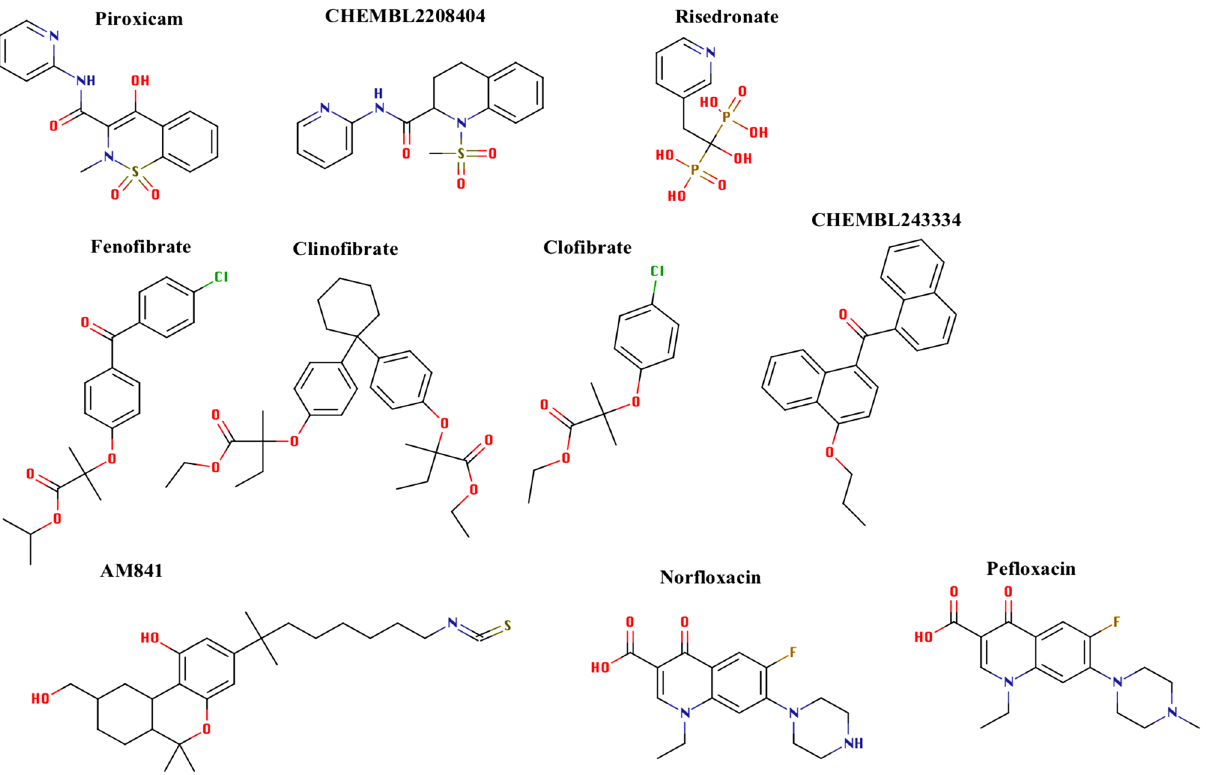
Figure 6. The chemical structures of the compounds predicted as potential ligands for GPCRs; Piroxicam & Risedronate (potential Glutamate receptor ligands), Fenofibrate, Clinofibrate & Clofibrate (Potential Cannabinoid receptor ligands), Norfloxacin & Pefloxacin (Potential 5-Hydroxytryptamine receptor ligands). The figure also includes the chemical structures of CHEMBL2208404: a glutamate receptor agonist listed in GLASS and is structurally similar to Piroxicam; CHEMBL243334: a cannabinoid receptor agonist listed in GLASS and is structurally similar to Fenofibrate; AM841 (a co-crystallized cannabinoid agonist). The figure was generated with MarvinSketch: https:// chema xon. com/ produ cts/